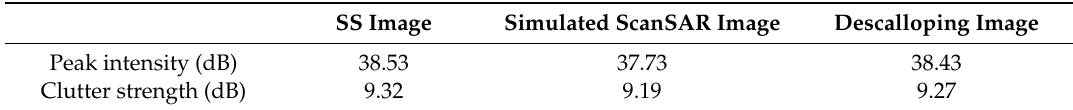
Table 2. E ff ects of descalloping on Table 2. Effects of descalloping on ships. Table 2. Effects of descalloping on ships.